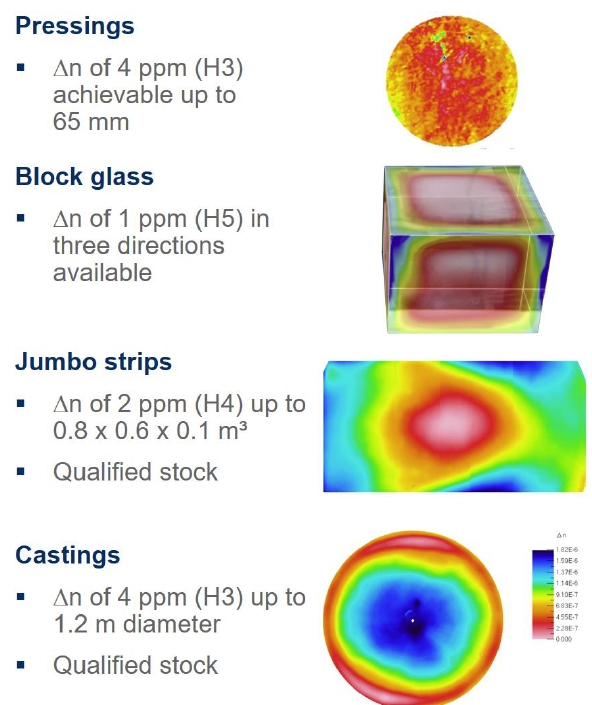
Fig. 2. Overview of different formats and geometries of SCHOTT N-BK7 ® with typical high homogeneity quality grades in false color code of interferometric measurement. Pressings are available up to 4 ppm (H3), while blocks and